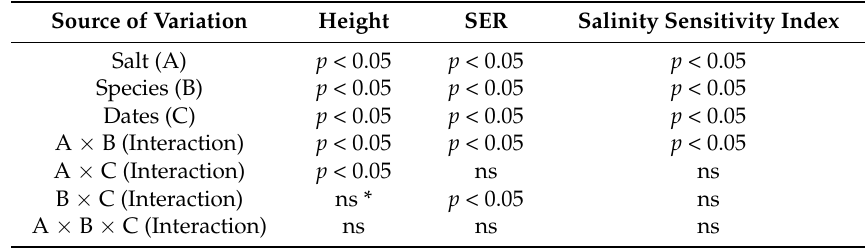
Table 2. Statistical significance of F ratios from the analysis of variance for stem height of seedlings, stem elongation rate (SER), and sensitivity index.